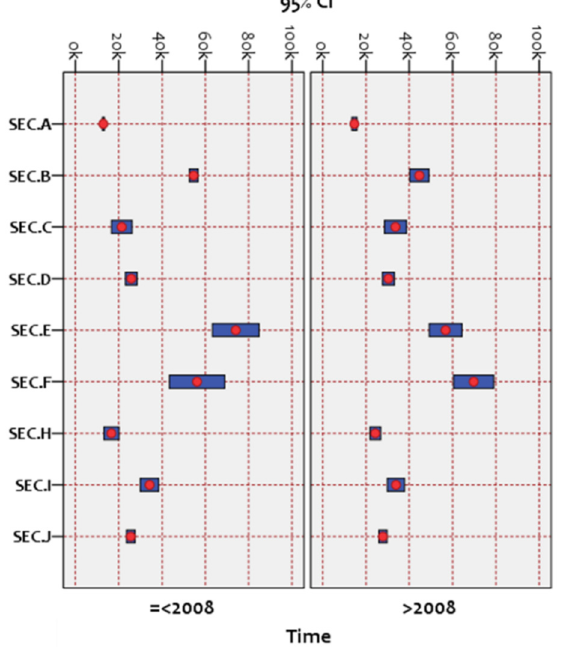
Figure 4. Error bars illustrating t -tests for the equality of means of GVA (pLU) for the pre- ( ≤ 2008) and on-crisis (>2008) grouping, for each sector. GVA prices are measured in EUR/LU (constant prices on 2008 basis).